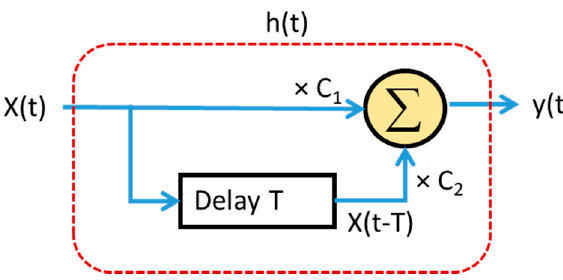
Figure 17. Single delay line canceler for two-pulse moving target indication (MTI).